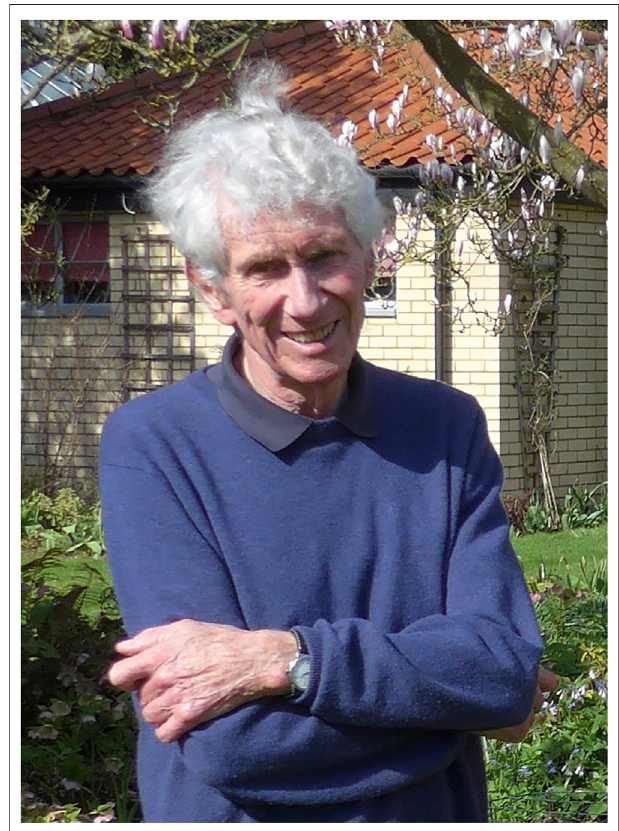
FIGURE | Ken on a visit to Cambridge in